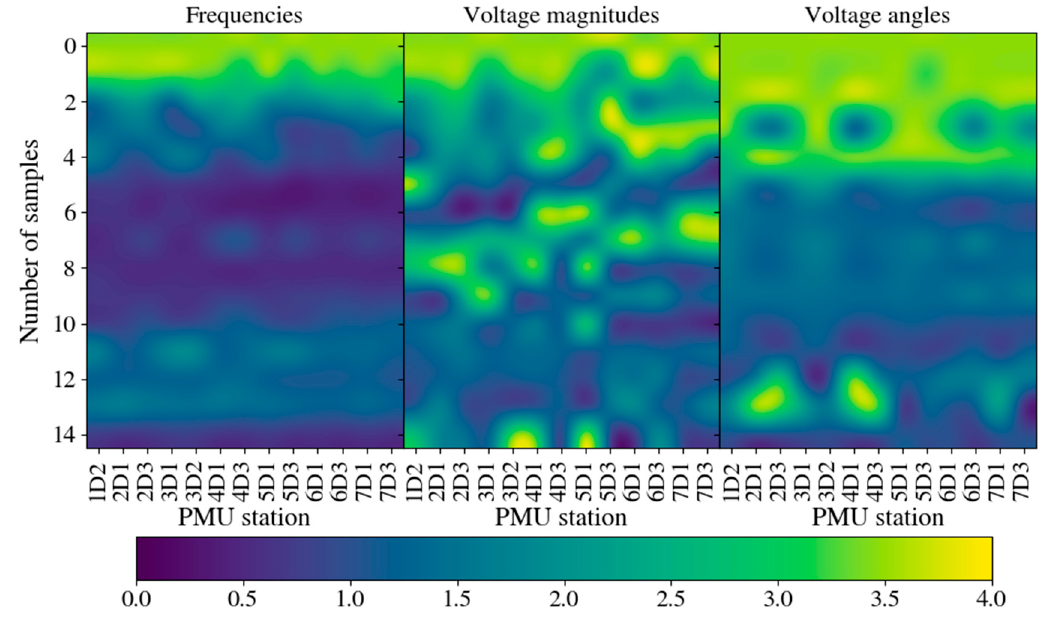
Figure 17. Anomaly scores for selected PMU samples from a DKW generator outage at station 1D1.